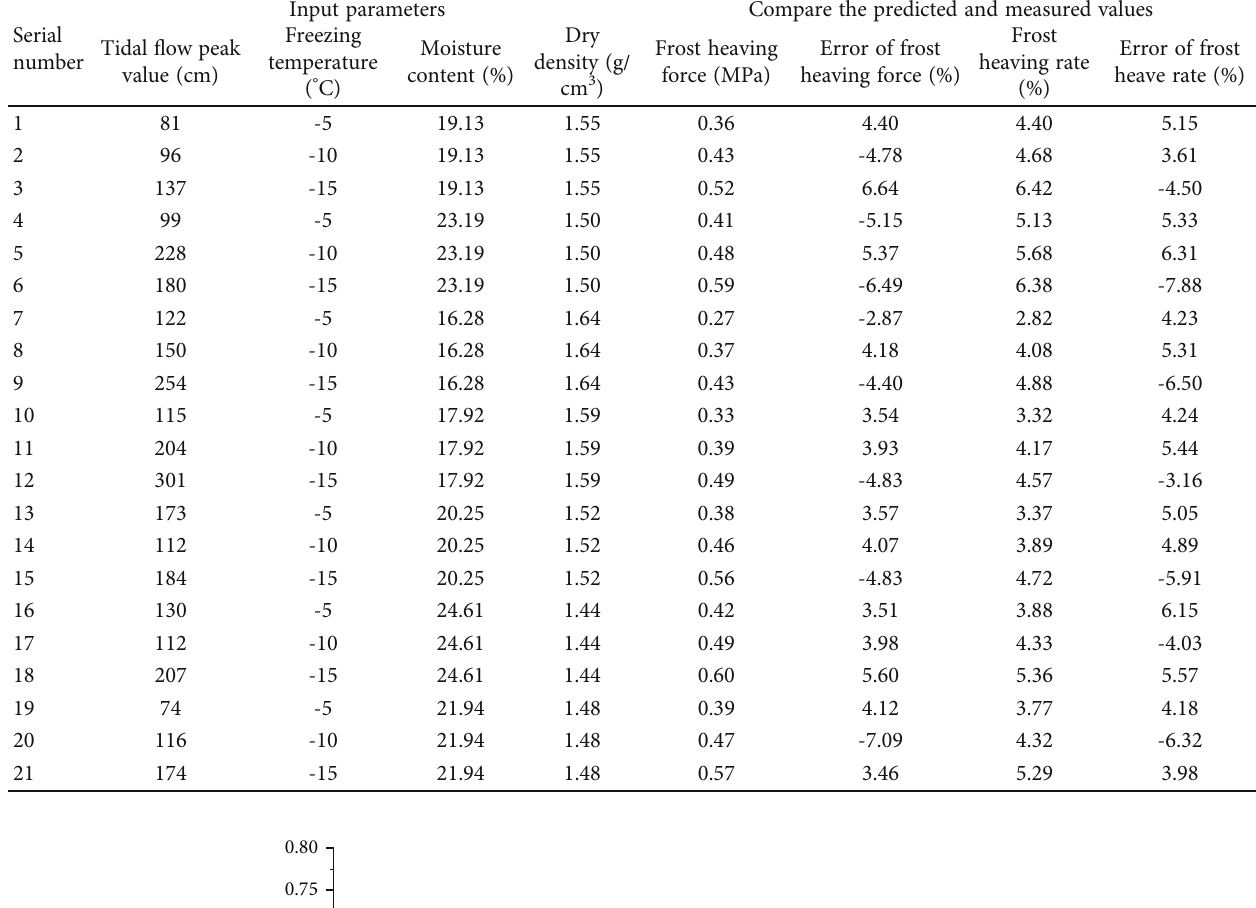
Table 4: Engineering prediction results of frost heave characteristics.